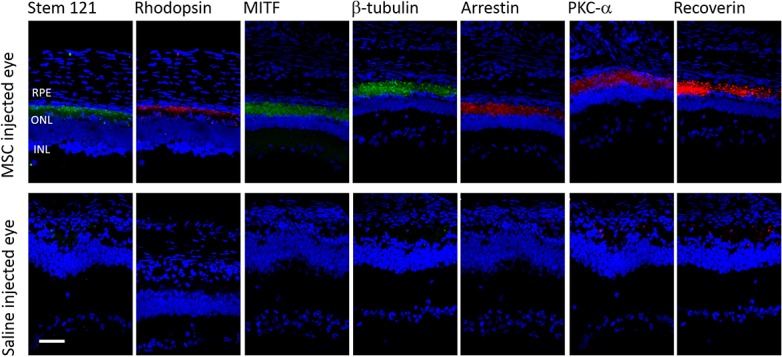
Immunohistochemistry of the injected eyes and control at day 70.Confocal microscopy at day 70 of the hWJ-MSCs and saline injected eye. Positive staining of the retinal antibody markers was detected in the hWJ-MSCs injected eyes but not in the saline injected eye. The antibodies used were Stem 121(green) for mesenchymal stem cells, Rhodopsin (red) for rod photoreceptors, MITF (green) for RPE specific markers, β tubulin (green) for immature neurons, anti-cone arrestin (red) for cone photoreceptors, PKC-α (red) for bipolar cells and recoverin (red) for cone bipolar. All slides were counterstained with DAPI (blue) to label the nucleus. Scale bar (white) represents 1000 μm.